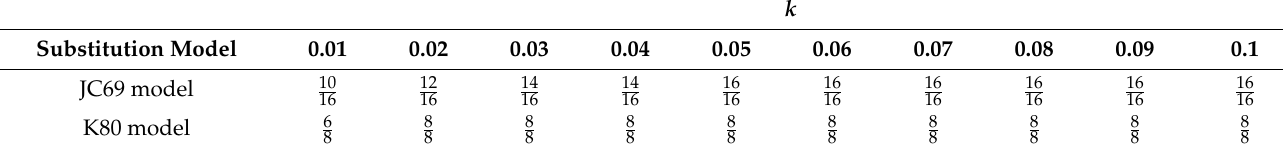
Table 4. The values R ( 3, k ) for the maximum likelihood tree. The difference between these two models is marked by the red color in the JC69 model.